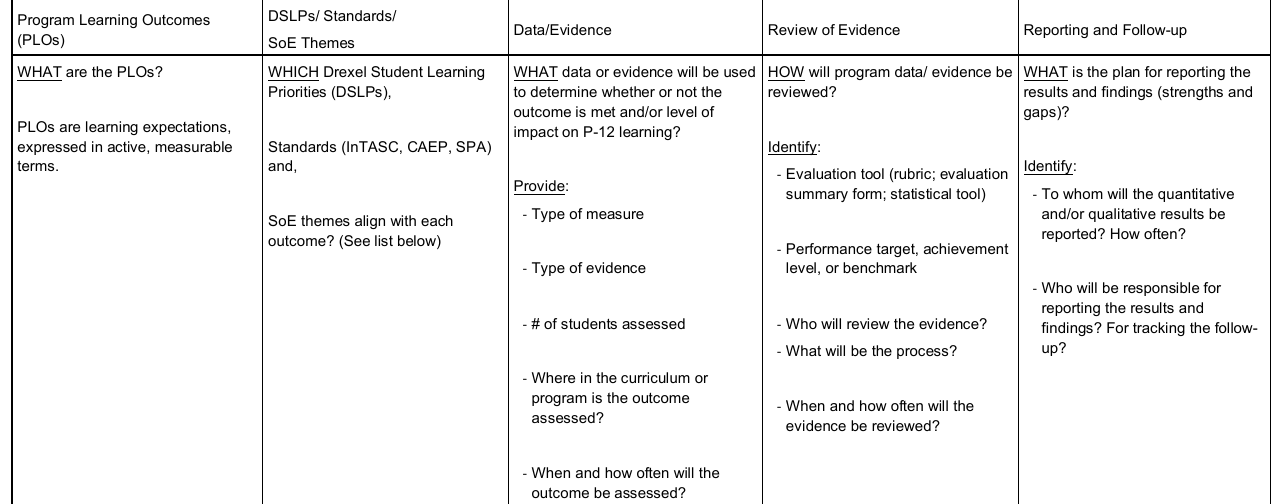
Table 6. SoE Program Assessment Planning Tool Program Learning Outcomes